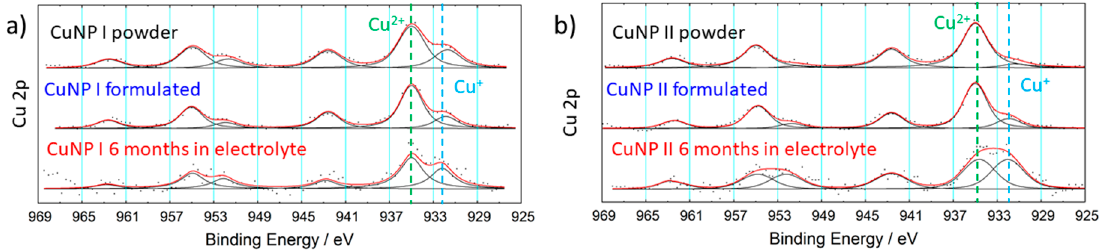
Figure 4. Effect of the presence of the electrolyte on the state of charge of metals. ( a , b ) Cu 2p signals of sample I and II.